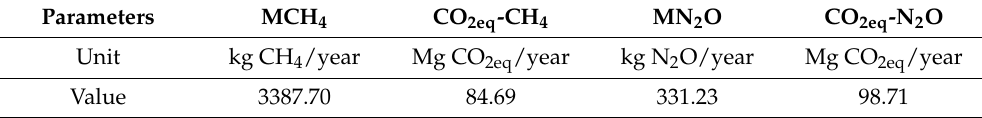
Table 4. Masses of methane and nitrous oxide and conversion to the equivalent of carbon